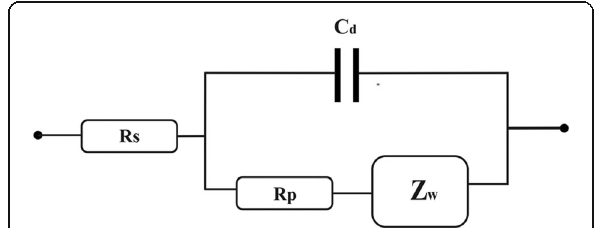
Fig. 13 An idealized Randles electrical equivalent circuit for an electrochemical reaction. C d , double-layer capacitor; R p , polarization resistance; R s , solution resistance; Z W , Warburg impedance. (Reprinted with permission from Reference Bansod et al. 2017).